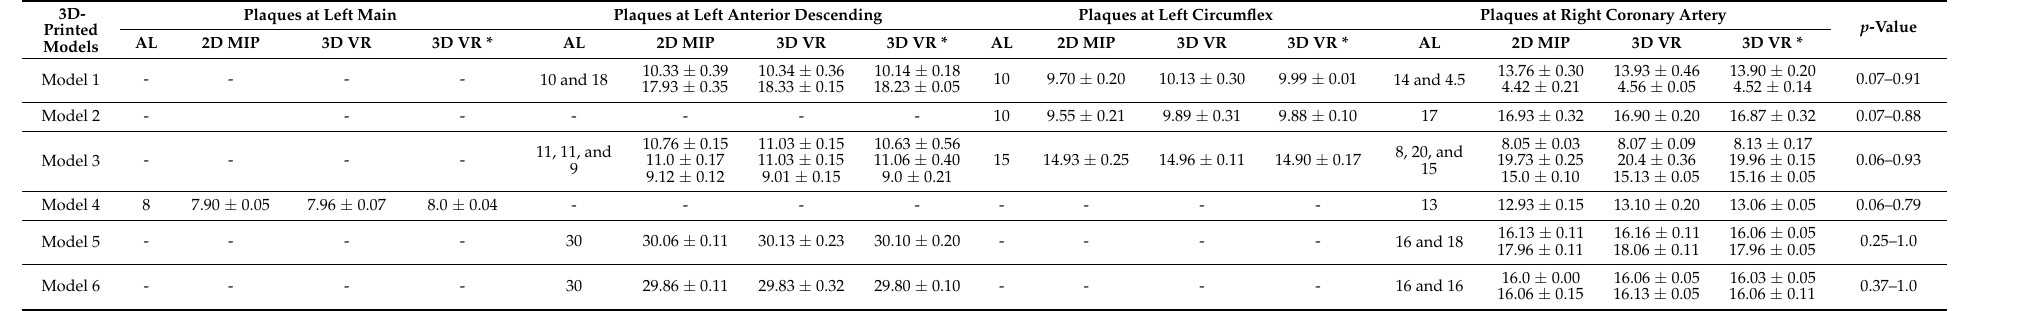
Abbreviations are the same as provided in Table 3. AL—actual